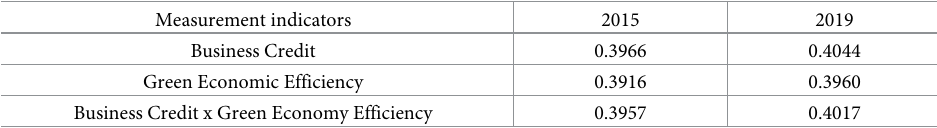
Table 4. Spatial correlation tests for core variables: Moran